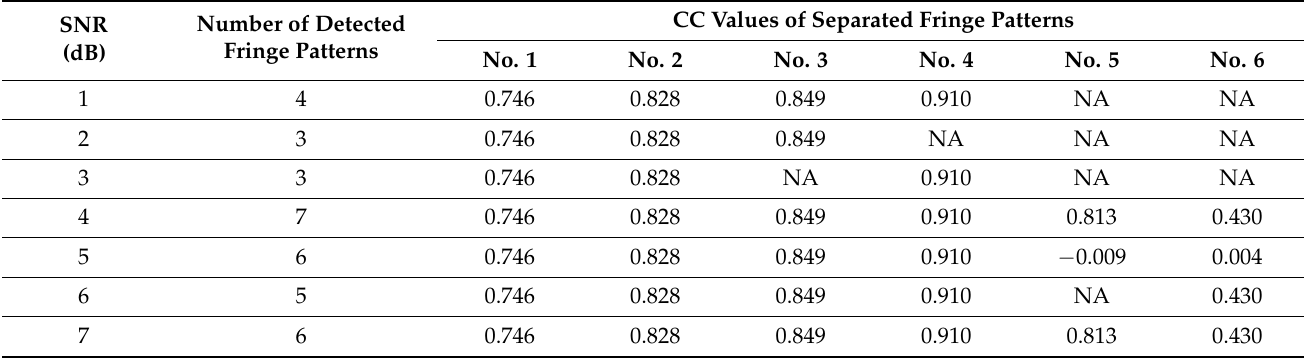
Table 6. The detected numbers of separated fringes and the corresponding CC values under different SNR values of the noisy mixed fringe pattern. (NA: not